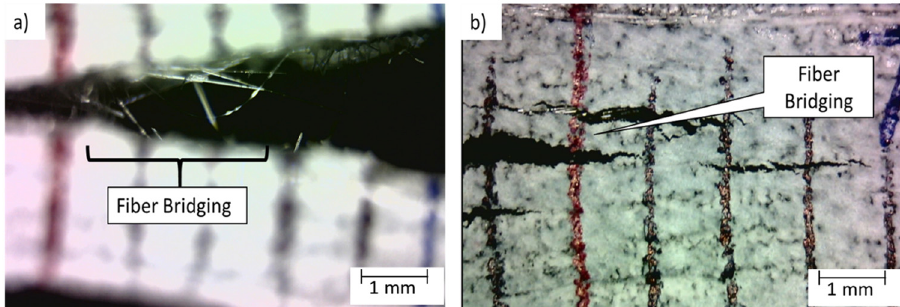
Figure 8: ( a ) and ( b ) Fiber bridging at DCB sample during crack